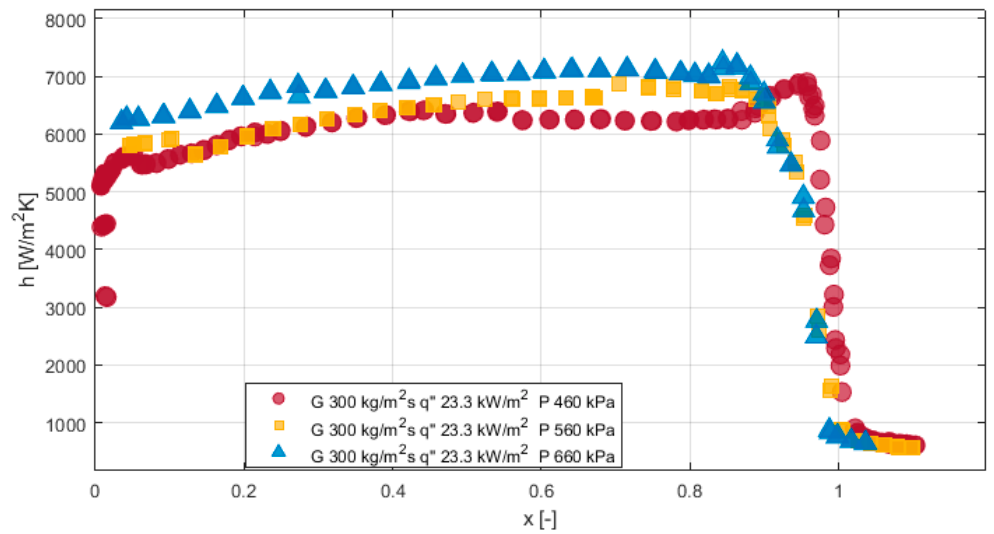
Figure 8. Effect of saturation pressure on heat transfer coefficient for mass flux of 300 kg/m 2 s and heat flux of 23.3 kW/m 2.